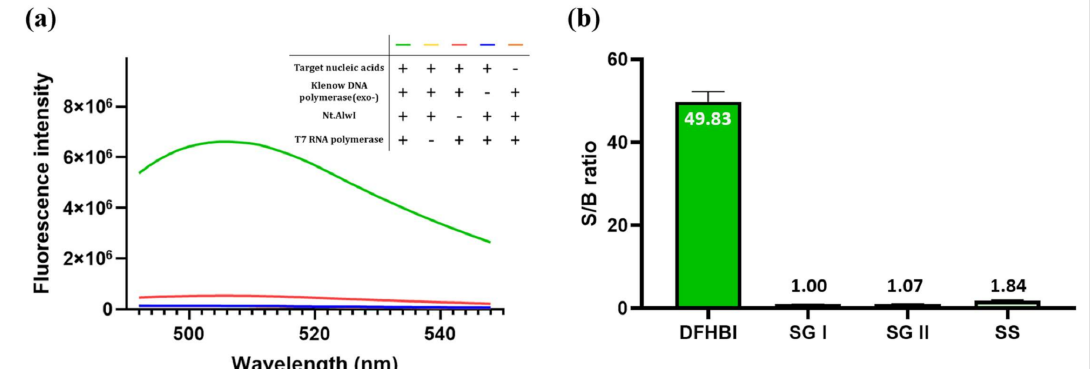
Figure 2. Detection feasibility of the proposed strategy. ( a ) Fluorescence emission spectra under different conditions. ( b ) The signal-to-background (S/B) ratio of the proposed strategy using different nucleic acid staining dyes such as DFHBI, SYBR Green I (SG I), SYBR Green II (SG II), and SYBR Safe (SS). All experiments were performed in